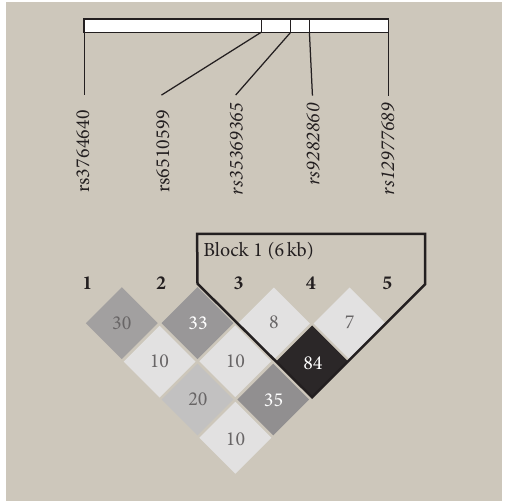
Figure 1: The 𝑟 2 values and the linkage disequilibrium (LD) plot between SNPs at STK11 locus. The color of the squares indicated the intensity of the linkage between SNPs. The 𝑟 2 values were showed in the squares. The triangular block circled the LD plot (confidence interval